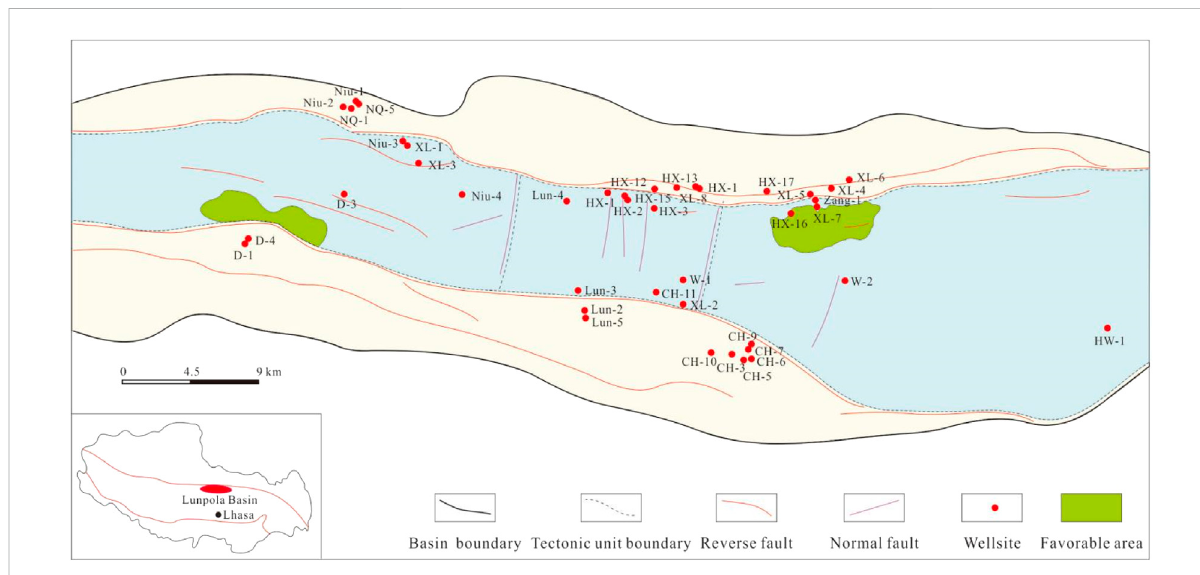
FIGURE 6 Prediction of the favorable areas for oil and gas exploration in the Lunpola